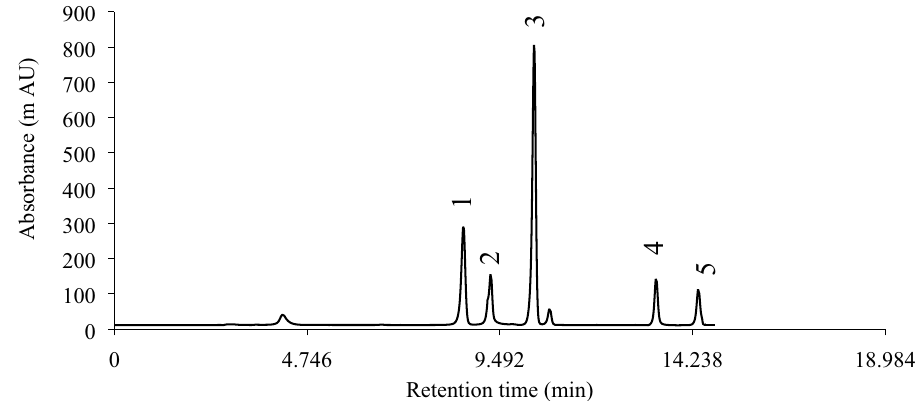
Figure 2. HPLC profile of a standard mixture of caffeic acid derivatives. Peak 1, caftaric acid; 2, chlorogenic acid; 3, chicoric acid; 4 cynarin, and 5, echinacoside.